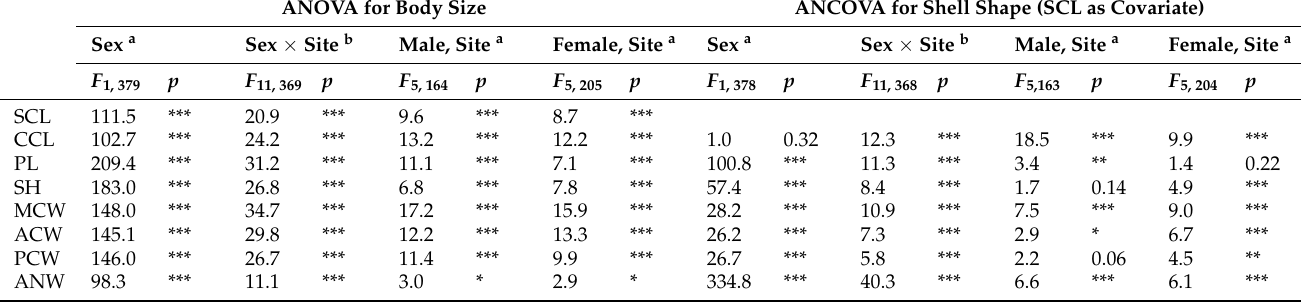
Table 2. Sexual and geographic differences in body size and shell shape among adults of Algerian T. graeca . F ( m − 1, e ) and p values for body size are from ANOVA, and for shell shape are from ANCOVA ( e , error degrees of freedom; Sample size ( n ) = e + m (number of groups being compared) + 1 (if the ANCOVA test case); a = One-way interaction; b = Two-way interaction; * = p < 0.05; ** = p <